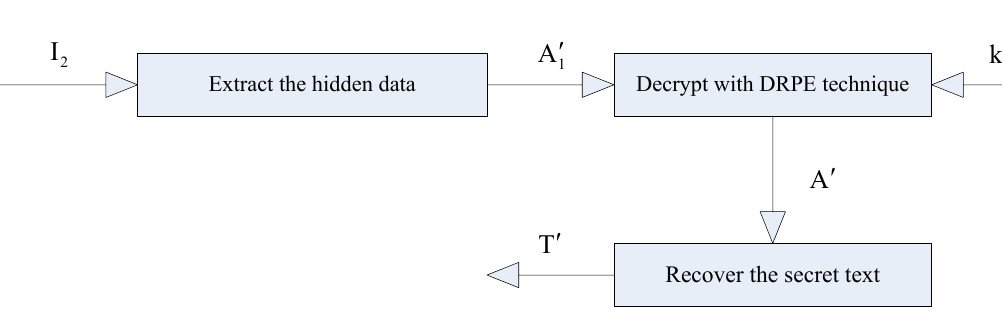
Figure 2. Extraction and recovery